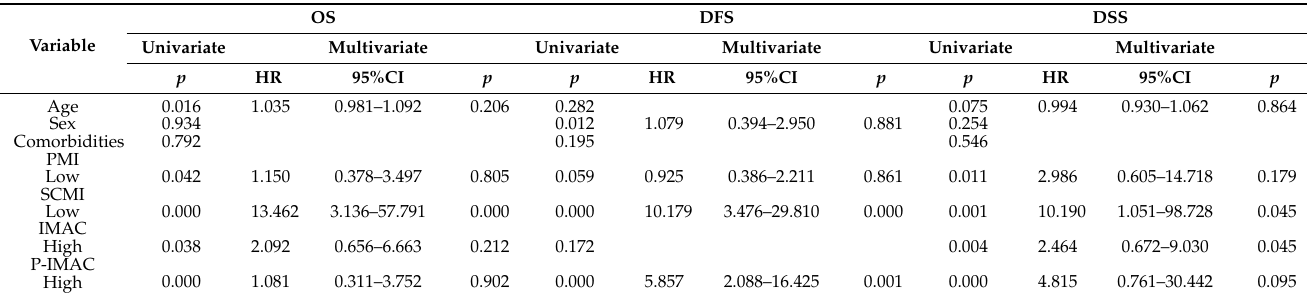
Figure 4. The group with lower preoperative SCMI and higher P-IMAC had a lower survival rate than the other groups. ( a ) The overall survival rate ( p < 0.0001); ( b ) the disease-free survival rate ( p < 0.0001); ( c ) the disease-specific survival rate in patients ( p < 0.0001). SCMI, sternocleidomastoid muscle mass index; P-IMAC, processus spinosus muscle—intramuscular adipose tissue content. Table 2. Univariate and multivariate analysis for OS, DFS, and DSS. OS, overall survival; DFS, disease-free survival; DSS, disease-specific survival; HR, hazard ratio; CI, confidence interval; PMI, psoas muscle mass index; SCMI, sternocleidomas- toid muscle mass index; IMAC, intramuscular adipose tissue content; P-IMAC, processus spinosus muscle—intramuscular adipose tissue